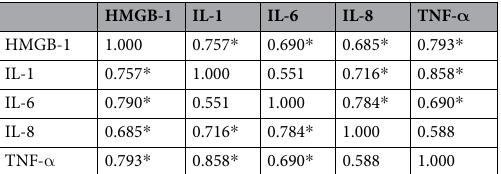
Table 6. Correlation coefficients between HMGB1, IL-1 β , IL-6, IL-8 and TNF- α in PICF (pg/ml). * p-value ≤ 0.05. The correlations between HMGB1, IL-1 β , IL-6, IL-8 and TNF- α in PICF were calculated with Pearson